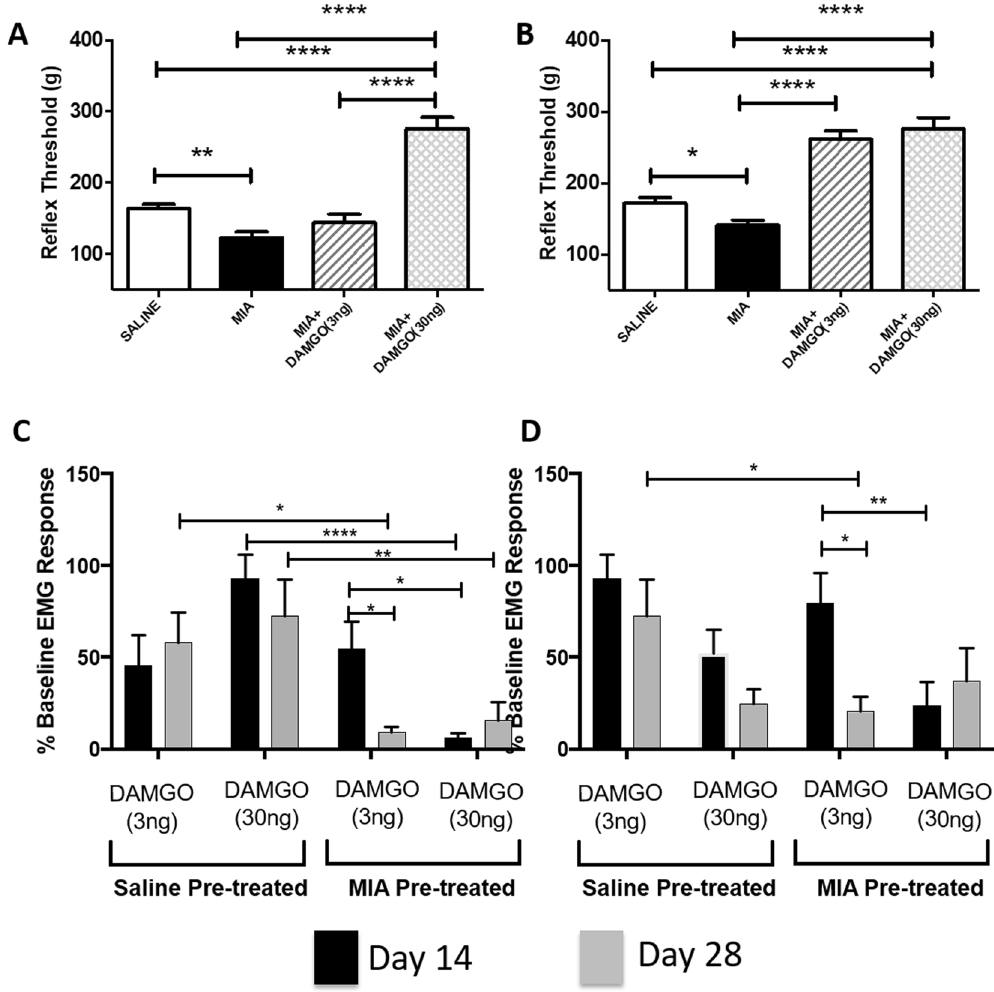
Figure 4. MIA leads to a increased sensitivity of endogenous opioid signaling within the RVM. EMG characterization of the nociceptive withdrawal reflexes in rats. Thresholds for mechanically evoked EMGs were significantly reduced in MIA-treated rats compared to saline rats at 14 ( A ) and 28 days ( B ) following intra-articular injection of MIA. Intra-RVM administration of 3 ng DAMGO did not alter MIA induced reductions in EMG threshold at Day 14 ( A ), but did reverse this reduction at Day 28 in MIA rats ( B ). Intra- RVM administration of DAMGO (3 ng) significantly inhibited EMG response magnitude to threshold vFh stimulation in saline (white bars) and MIA (black bars) treated rats at Day 14 compared to baseline (pre-drug) values. Low dose DAMGO (3 ng) was reduced EMG responses to threshold stimuli ( C ) in MIA treated rats at both Day 28 compared to saline treated controls but high dose DAMGO (30 ng) reduced responses at both Day14 and 28. A similar but not identical pattern was seen following DAMGO to responses to suprathreshold stimuli ( D ). Threshold determinations were compared using a one-way ANOVA with Bonferroni post-test. EMG magnitude and duration were compared between groups using a two-way repeated measures ANOVA with Sidak post-hoc test ** p < 0.01, *** p < 0.001, **** p < 0.0001. Day 14: MIA (n = 27 rats); Saline (n = 29 rats). Day 28: MIA (n = 50 rats); Saline (n = 38 rats). All data are presented as mean ±